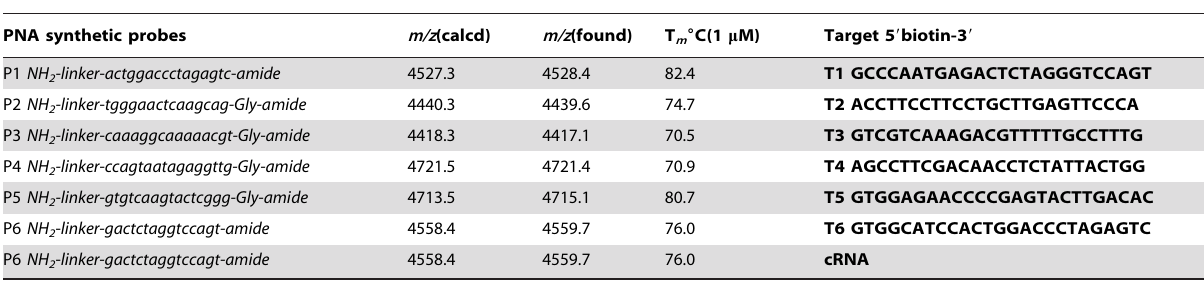
Table 1. HER2 PNA probes and targets.